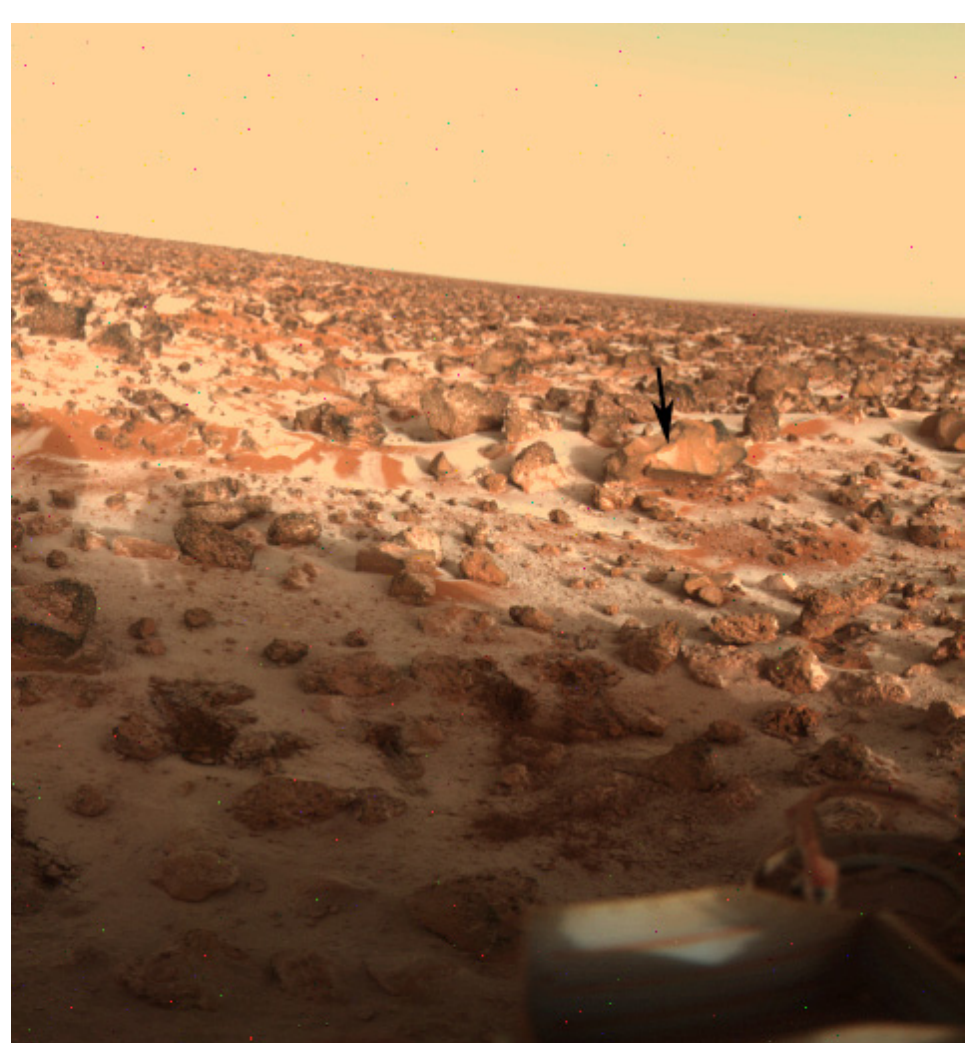
Figure 6. Possible extraterrestrial endolithic habitat on Utopia Planitia, Mars, where water-ice frost formation (arrow), conditions for stable liquid water, and suitable rock types